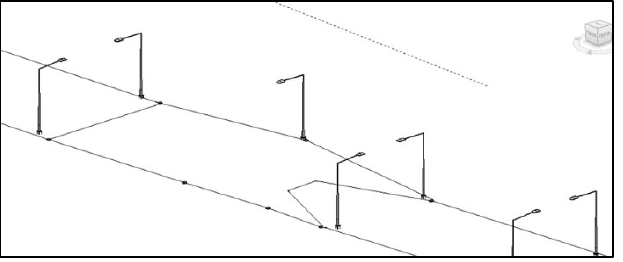
Figure 12. Public street lighting system model on Revit.